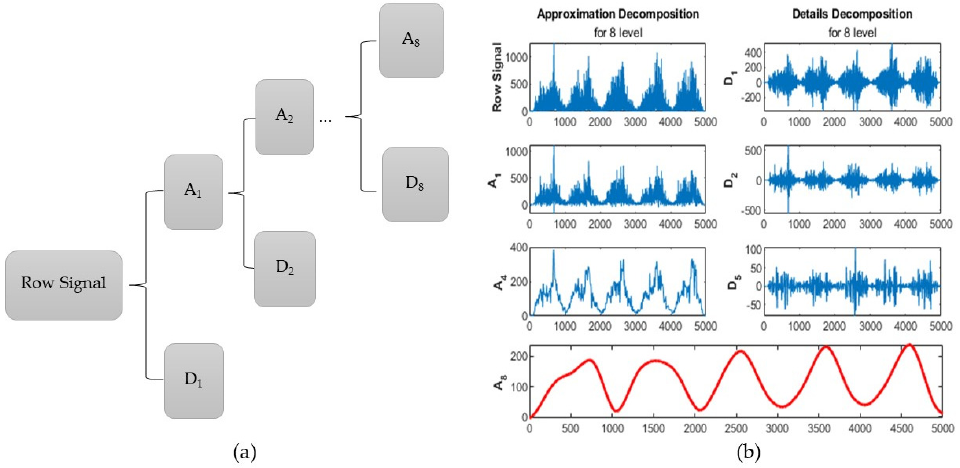
Figure 4. Discrete wavelet transform (DWT) ( a ) decomposition tree; ( b ) decomposition of sEMG signal using wavelet technique.